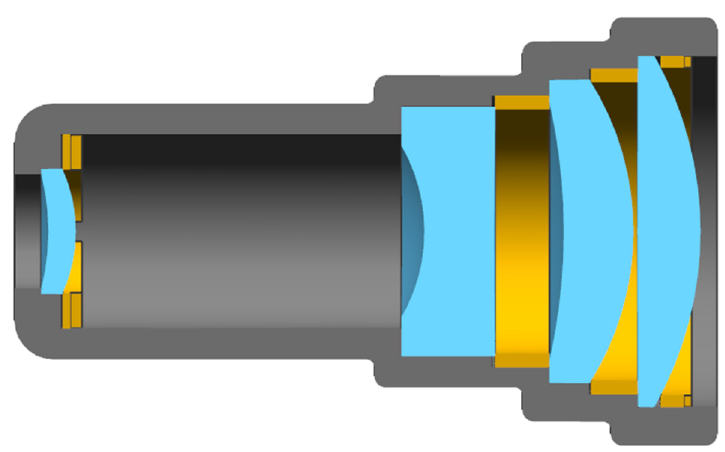
Figure 4. The structural profile of the optical system.